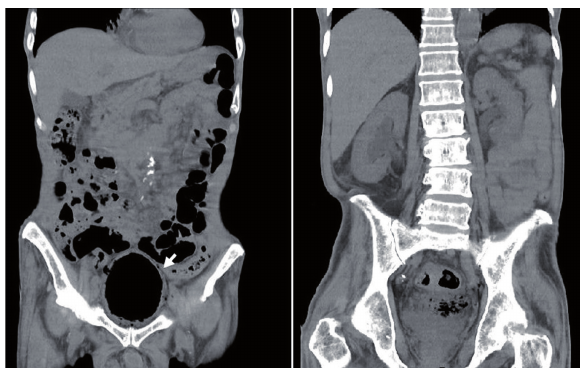
figure 2 - Abdominal computed tomography revealed bladder tamponade with massive air accumulation in bladder lumen and bladder wall (arrow), which leaded to bilateral